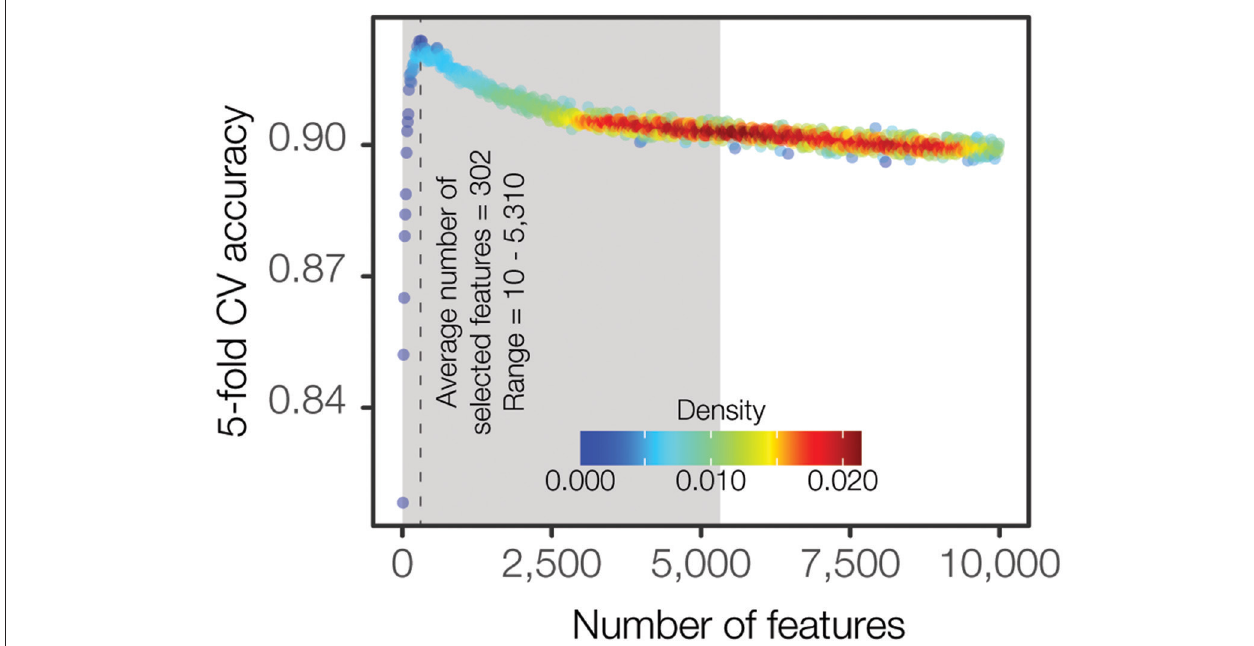
FIGURE 3 | Density plot representing the F 1 accuracy achieved by varying number of features. F 1 accuracy from 5-fold cross validation is iteratively computed starting with 100 of the most important features determined by Gini importance and incremented by 10 features at each iteration. Each point represents the average F 1 accuracy across each of the 27 serogroup classes. Kernel density estimation is calculated to highlight the abundance of similar, uninformative features where F 1 accuracy provides diminishing returns.